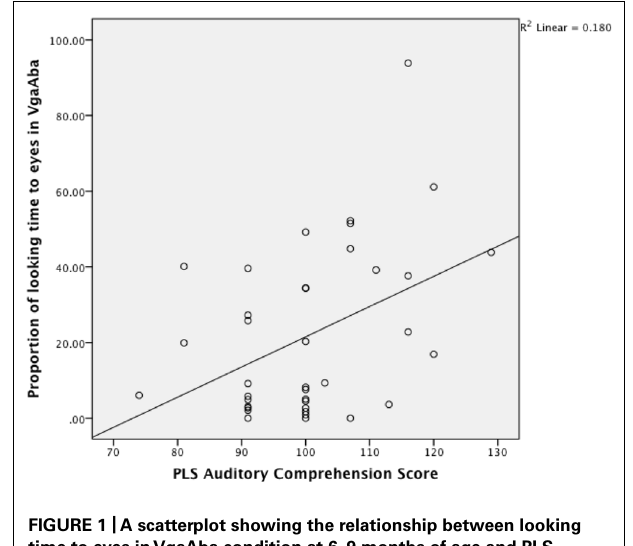
FIGURE 1 |A scatterplot showing the relationship between looking time to eyes inVgaAba condition at 6–9 months of age and PLS auditory comprehension scale at 14–16 months.